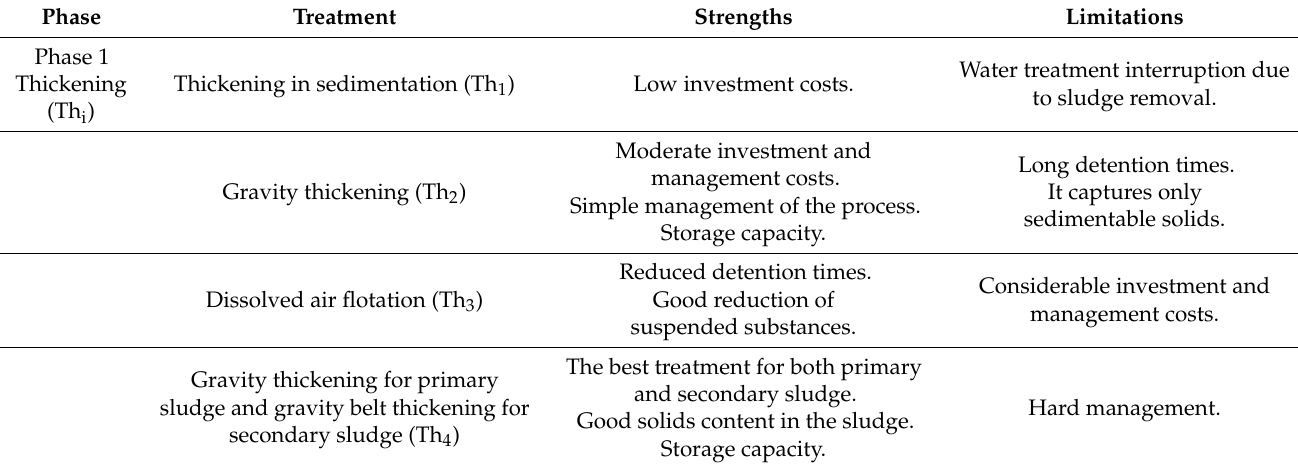
Table 2. Strengths and limitations of all considered alternatives to carry out the thickening treatments of the modeled SSTS. Phase Treatment